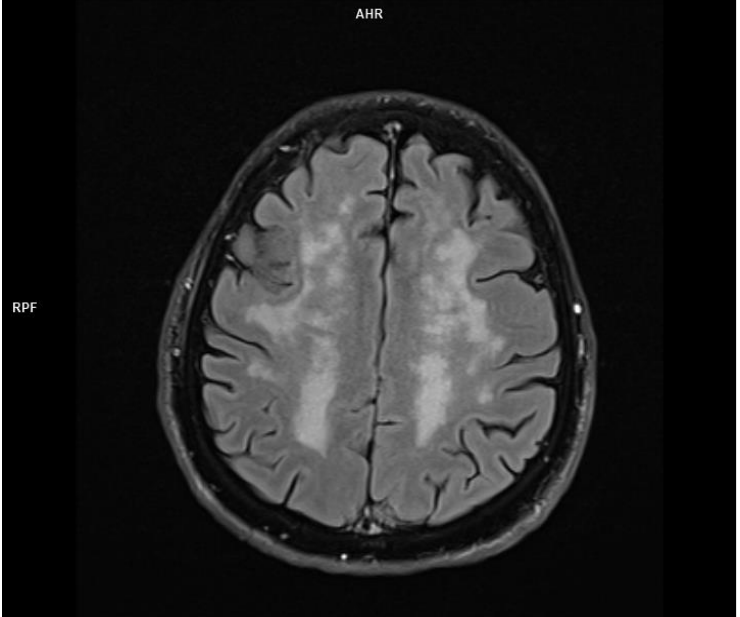
Figure 4. Diffuse hyperintense areas of the subcortical white matter — Flair sequence (MRI imaging).